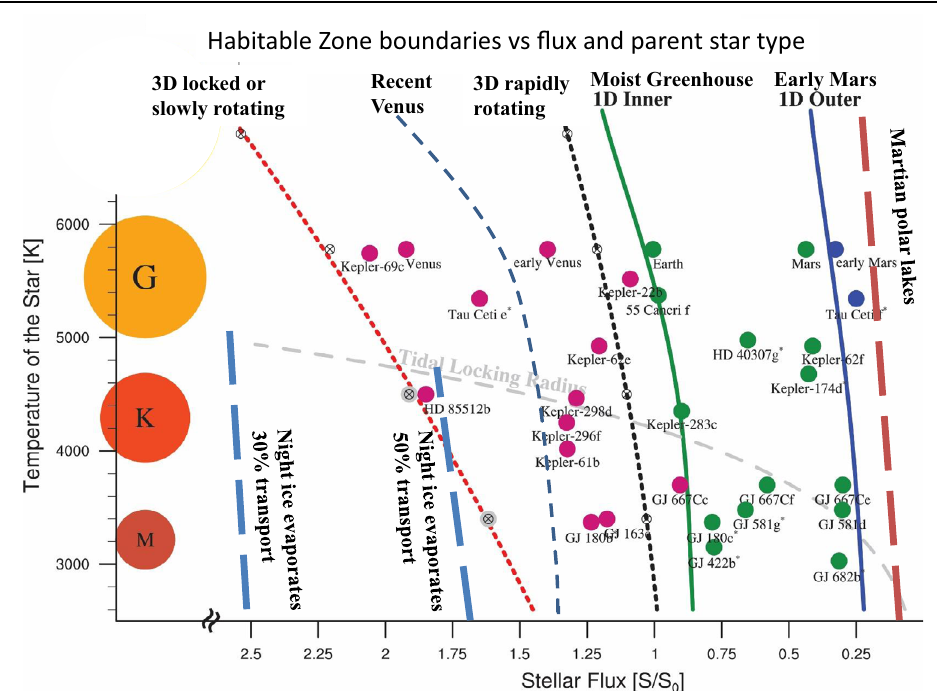
Fig. 1 | Habitable Zone boundaries as a function of stellar type and radiative fl ux received from the host star, relative to Earth. Long-dashed lines represent theextendedboundariesduetosubglacialliquidwatersuggestedinthiswork:blue for the inner HZ boundary (night-side ice evaporates) and red for the outer one (Martianpolar lakes).Greenand blue lines denote theinner (runawaygreenhouse) and outer (maximum CO 2 greenhouse) HZ boundaries, respectively, using the 1-D